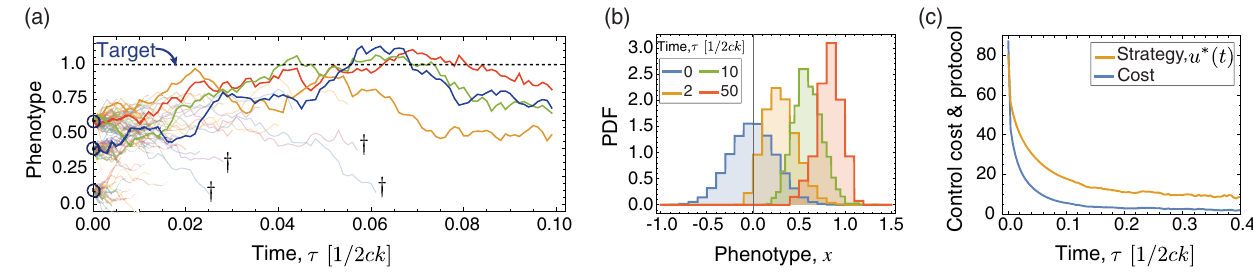
FIG. 2. Artificial selection with stochastic optimal annihilation. (a) Phenotypic trajectories starting from three distinct initial states (open circles) are shown for evolution under natural selection in a 1D quadratic adaptive landscape F ð x Þ ¼ − cx 2 , where x is the phenotype centered around its optimum under natural selection. The trajectories are annihilated ( † and low opacity lines) with a rate proportional to the cost of their deviation from target throughout evolution (dotted line), V ðj x − x (cid:3) jÞ = λ [Eq. (8)]. At each time point, the survived trajectories characterize the ensemble of evolutionary states for evolution under optimal artificial selection to reach the target at x (cid:3) ¼ 1 . Control is designed under the assumption of infinite horizon. (b) The probability density function (PDF) shows the distribution of phenotypes for populations evolving subject to the annihilation protocol in (A). Populations start from an uncontrolled and natural state (blue distribution), and as a result of control annihilation, their distributions move toward the desired target at x (cid:3) ¼ 1 (colors). Bu 2 (blue) are shown as a (c) The expected control strategy u (cid:3) ð t Þ ¼ − ð 1 = λ Þ kg ð x − x (cid:3) Þ (orange) and the cost of control V ðj x − x (cid:3) jÞ þ 1 2 function of time, as populations are driven from their natural state toward the target state. Time is measured in units of the characteristic time for natural evolution ( 1 = 2 kc ). Parameters are k ¼ 0 . 4 , c ¼ 1 , λ ¼ 0 . 01 , g ¼ 4